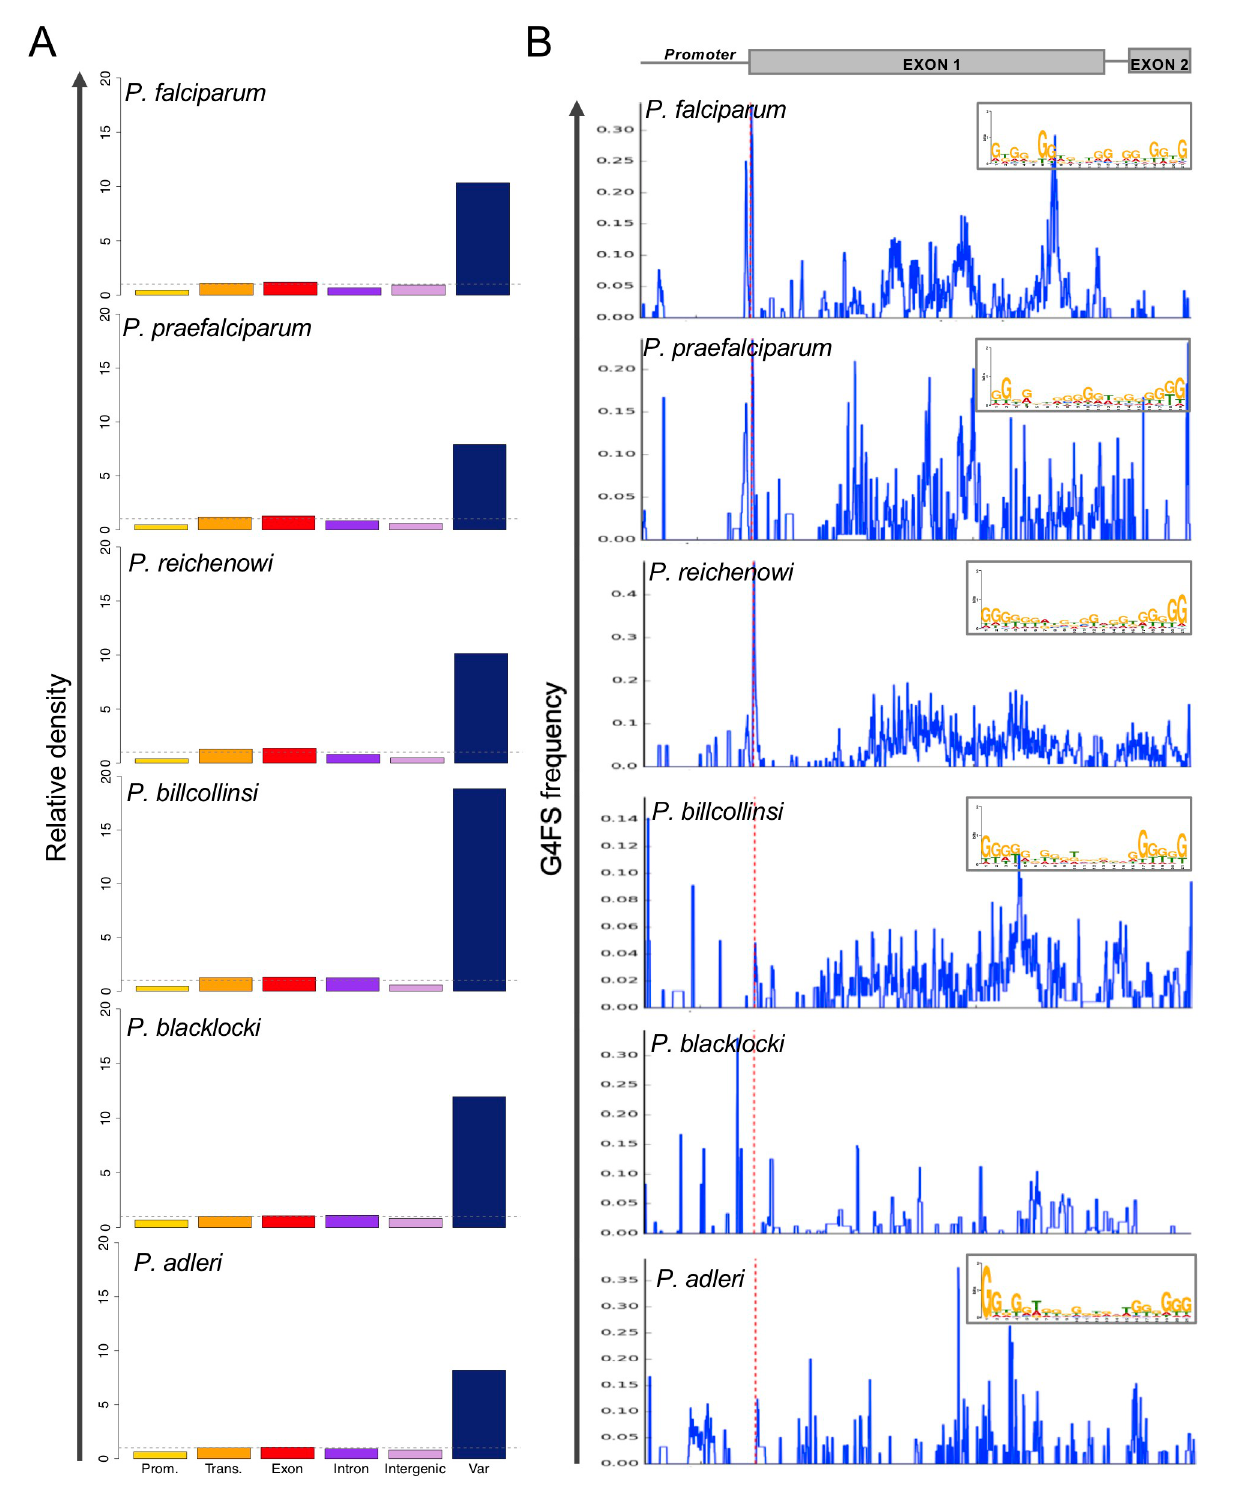
Fig 4. G4FS distribution in Laverania species. (A) Relative density of G4FS for different genome features of various Plasmodium species from Laverania subgenus (G4Hunter, threshold 1.2). Plasmodium species are sorted according to their genetic distance from P . falciparum with the closest species on top. G4FS presented here are the results of G4Hunter analysis after applying a threshold of 1.2. (B) Metagene profiles of G4FS in var genes of Laverania